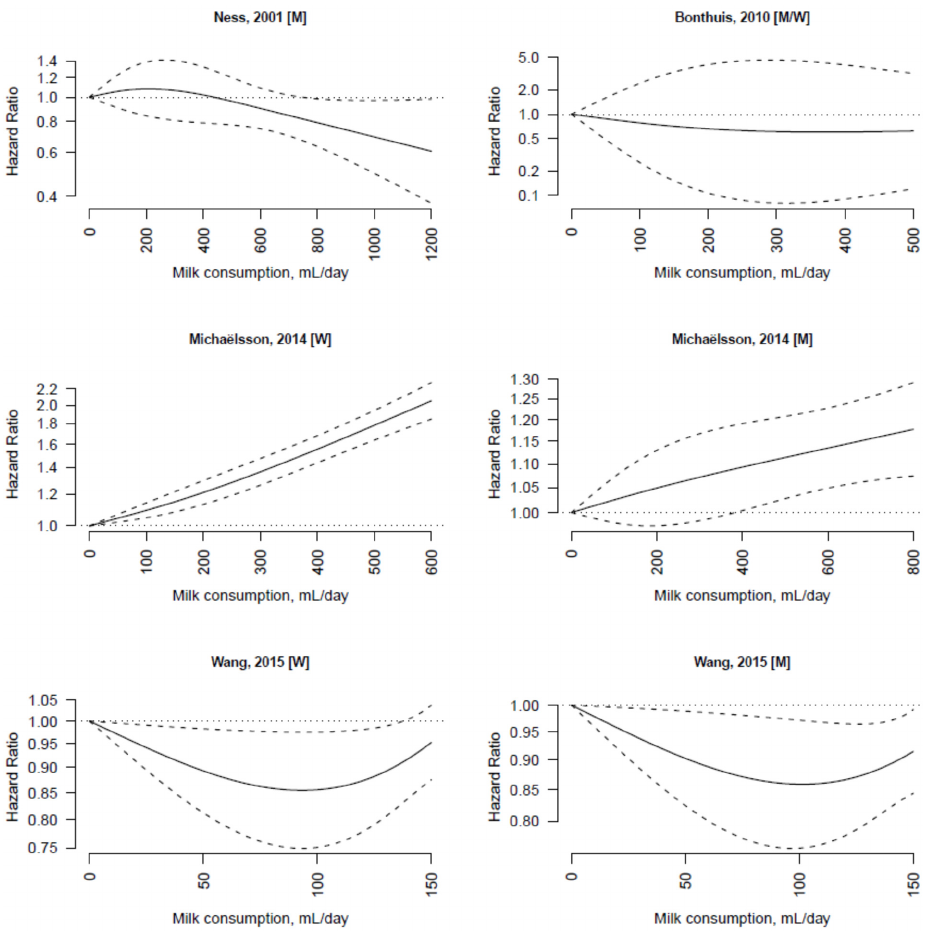
Figure 3. Dose-response association between non-fermented milk consumption and cardiovascular disease mortality in individual studies. The hazard ratios are plotted on a log scale.